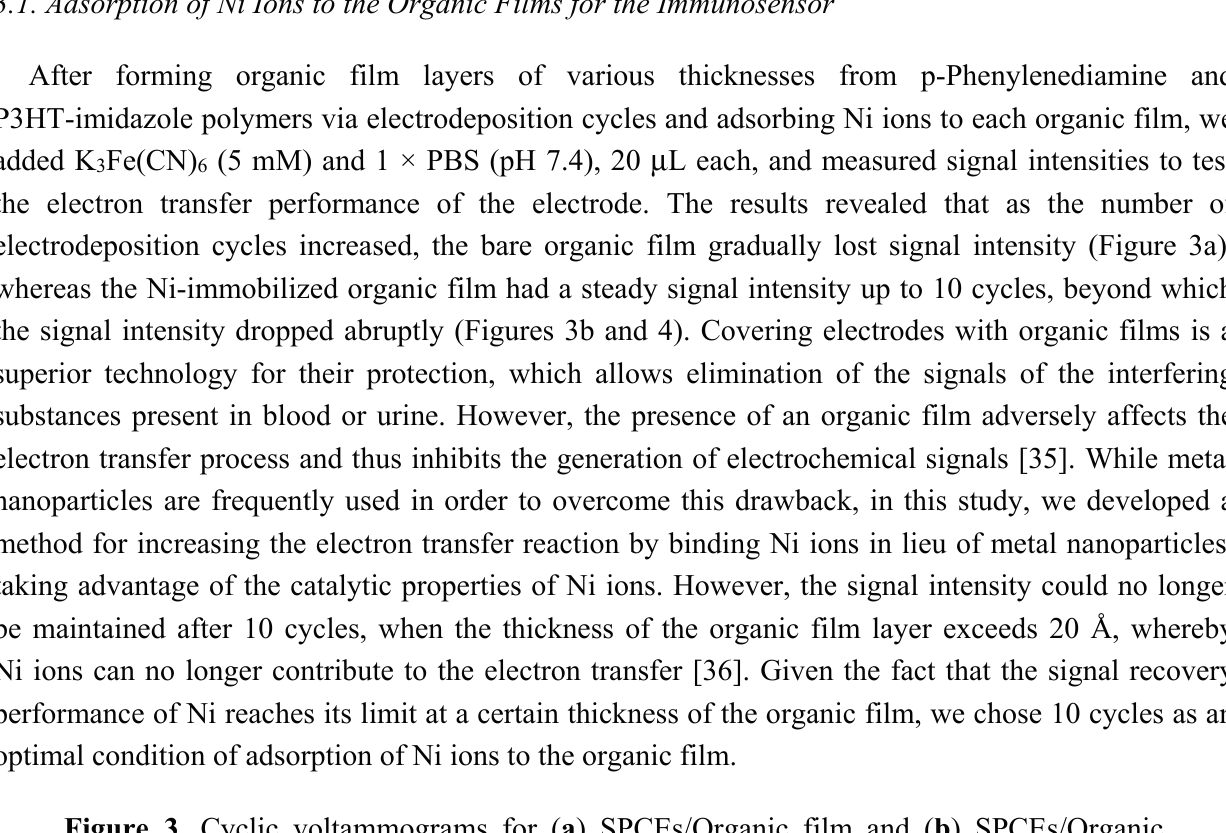
Figure 3. Cyclic voltammograms for ( a ) SPCEs/Organic film and ( b ) SPCEs/Organic film/Ni surface recorded in phosphate buffer solution containing 2 mM K 3 Fe(CN) 6 .